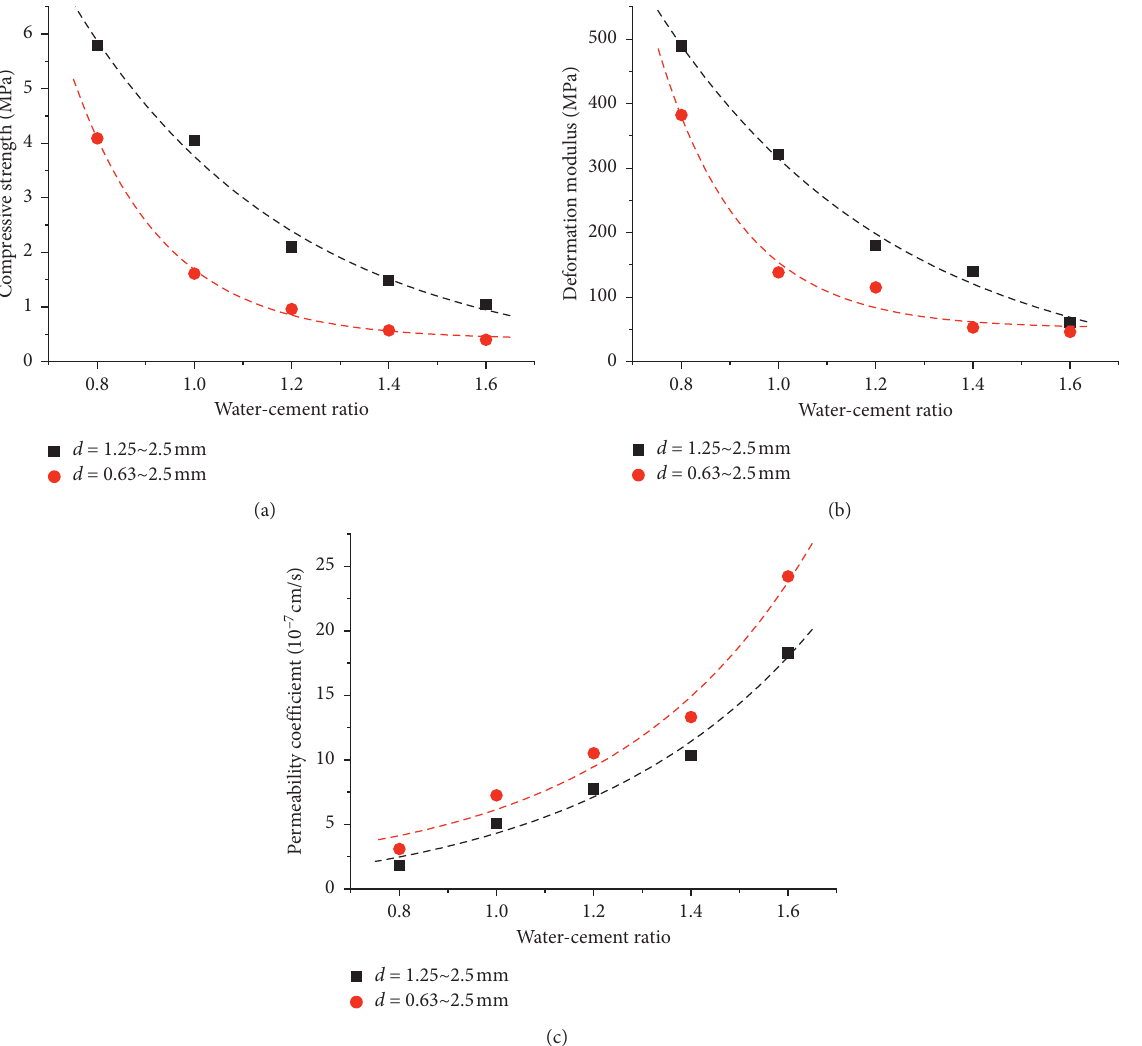
Figure 11: Fitting curves of reinforcement effect of the grouted body and water-cement ratio. (a) 3d compressive strength. (b) 3d deformation modulus. (c) 1d permeability